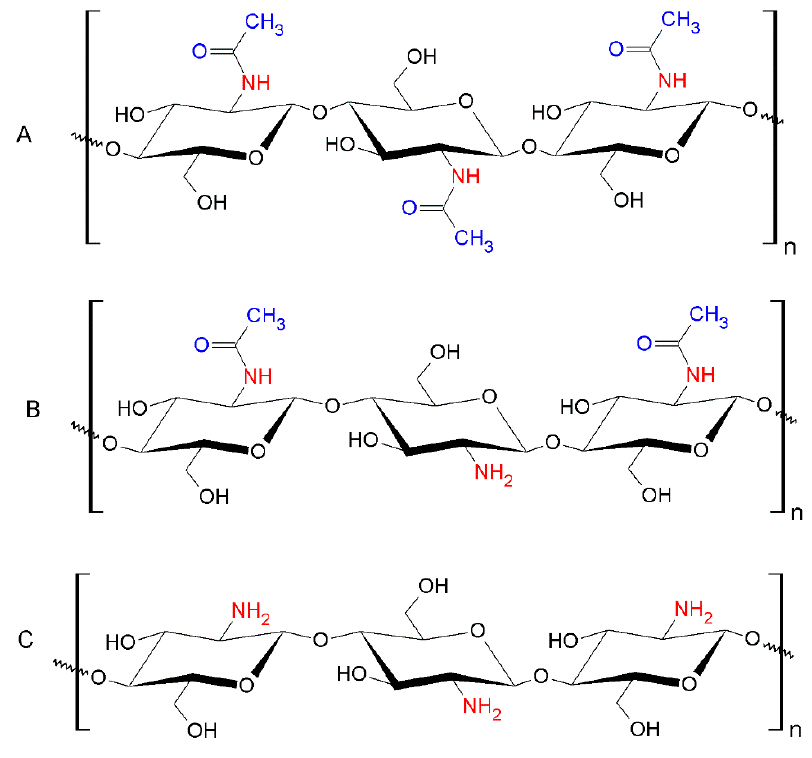
Figure 19. Structure of chitosan pristine bionanomolecules.